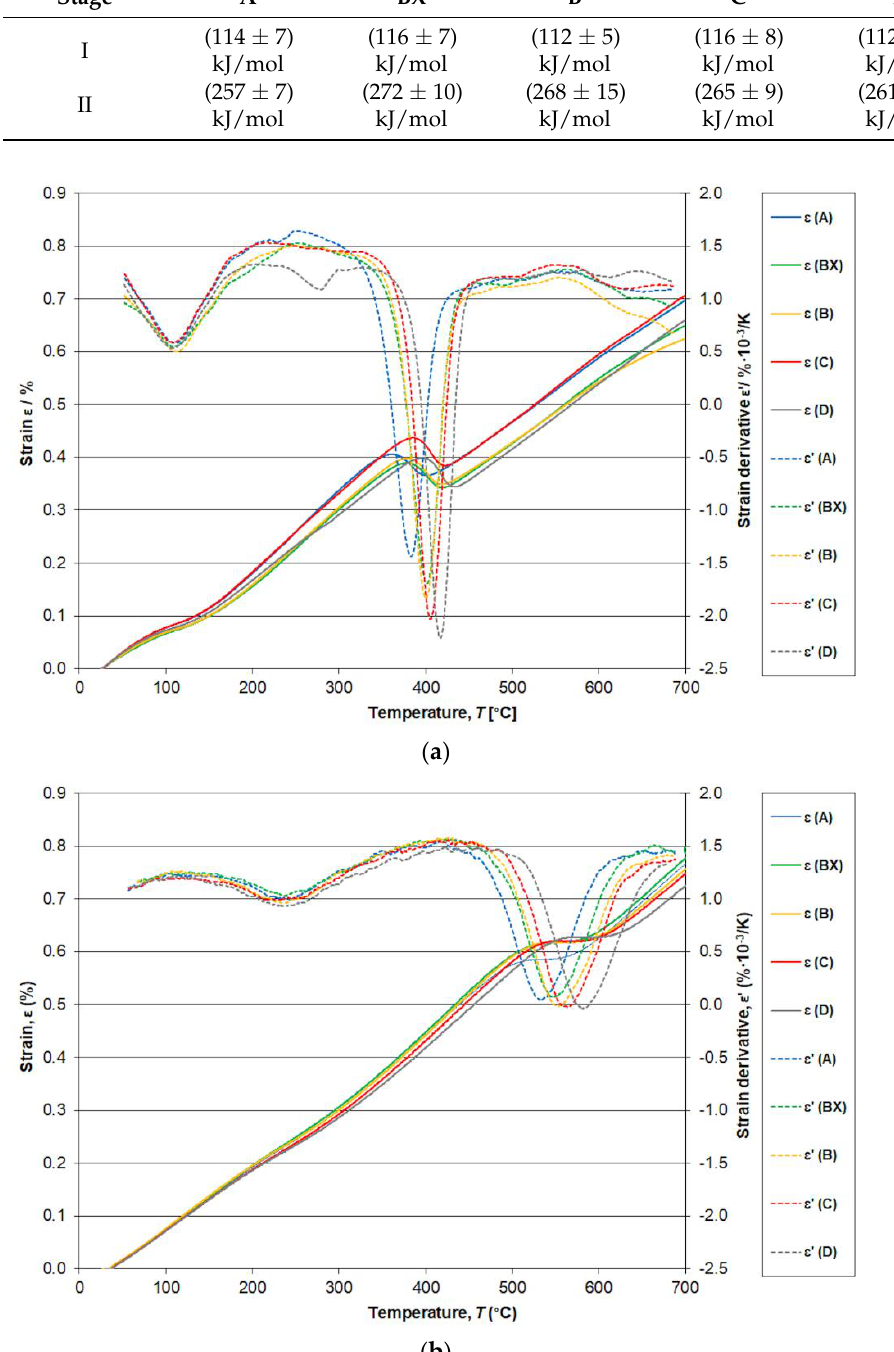
Figure 3. Thermal strain ( ε ) and its derivative (ε’) for steels A, BX, B, C , and D hardened from 900 °C and tempered using heating rate β = 0.005 K/s ( a ) and β = 50 K/s ( b ). Table 2. Temperatures corresponding to inflection points ( T i) at different heating rates ( β ) for stage I of tempering in the dilatometry data.